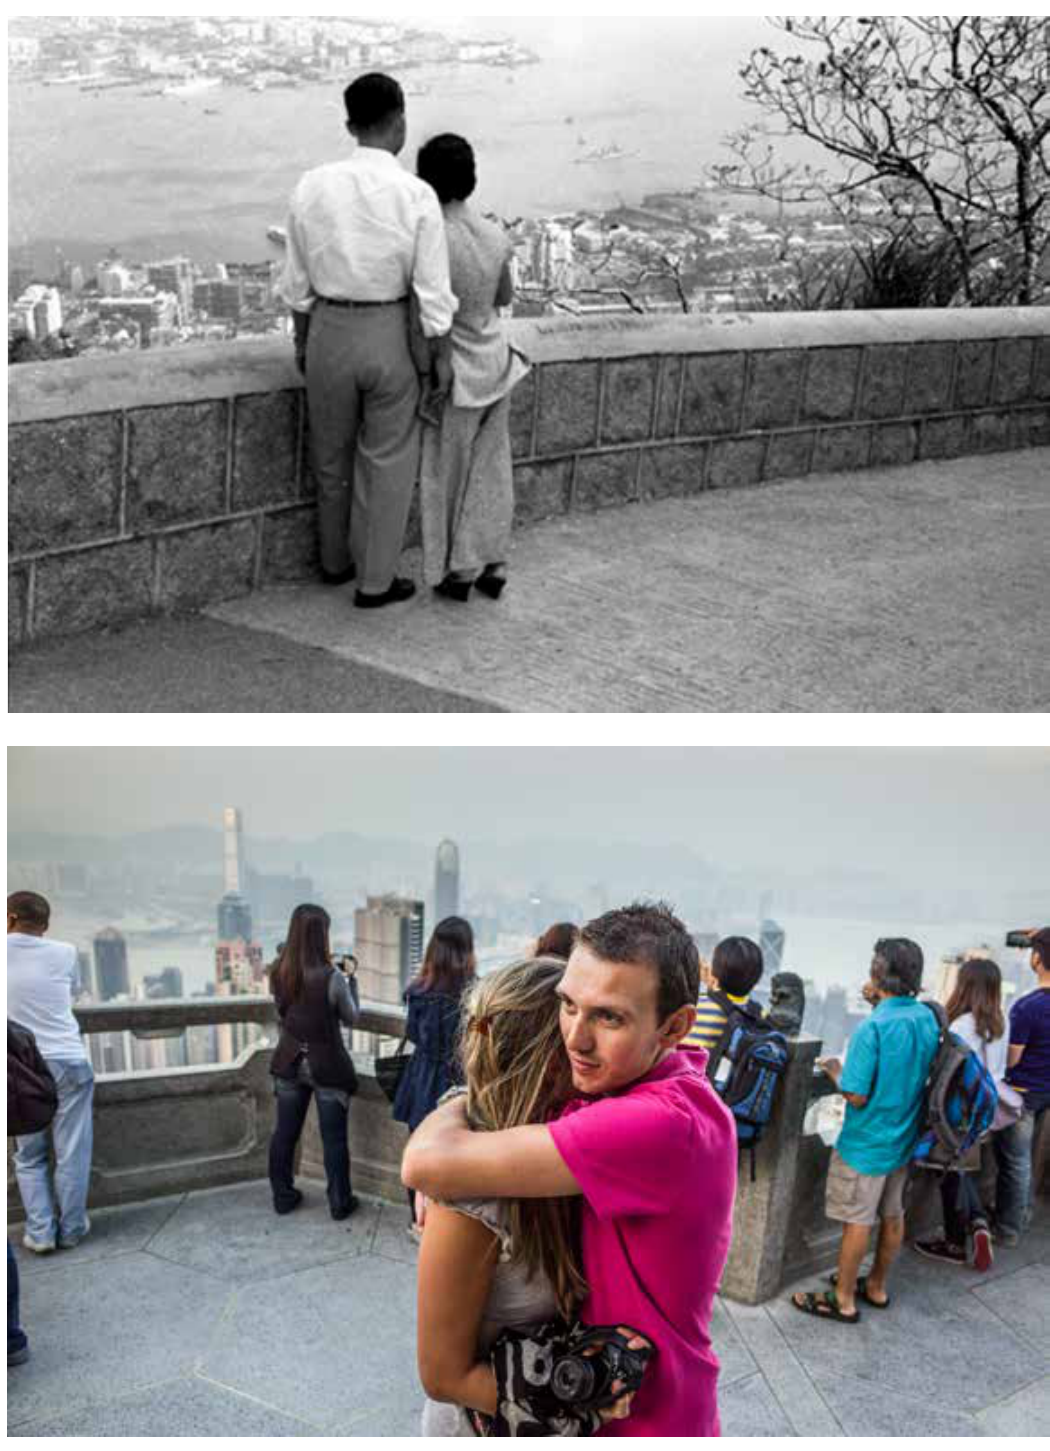
Figure 5a (top): Nick Howard, A Couple at the Mid-level, Hong Kong Island, 1957/58.